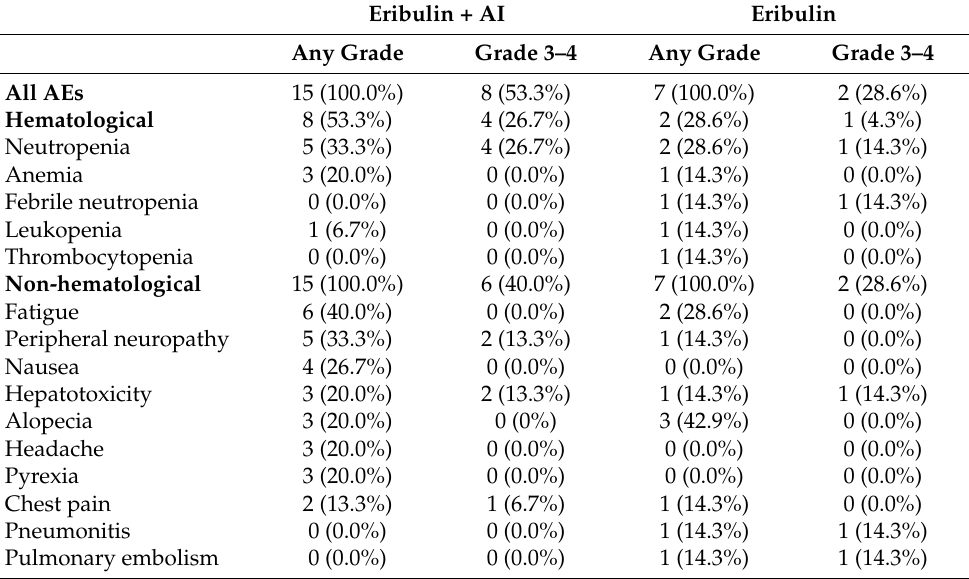
Table 3. Adverse events with an incidence of at least 14% and/or grade ≥ 3 in the safety